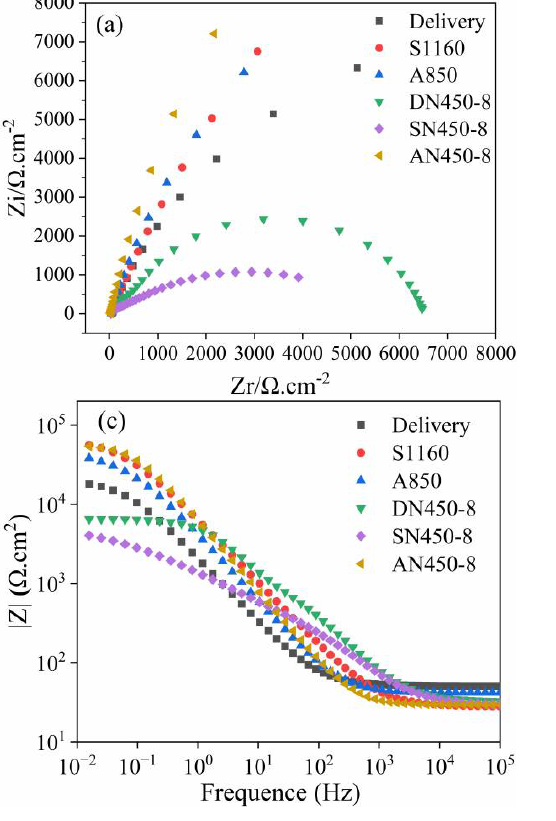
Figure 9. Nyquist and Bode spots of AISI 430 stainless steel before and after plasma nitriding in a 3.5% NaCl solution. ( a , b ) Nyquist spectra, ( c ) Bode-impedance moduli, and ( d ) Bode-phase angle.